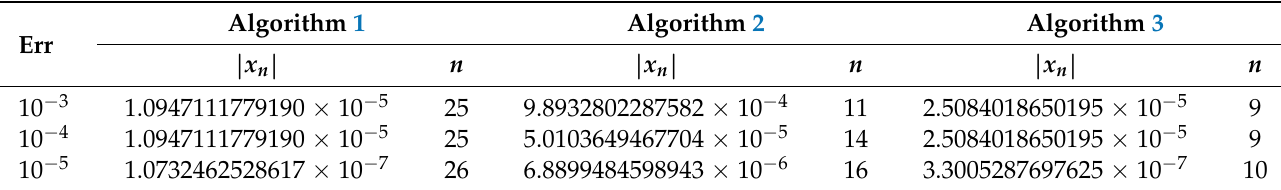
Table 1. Numerical results for Example 4 in Case I.